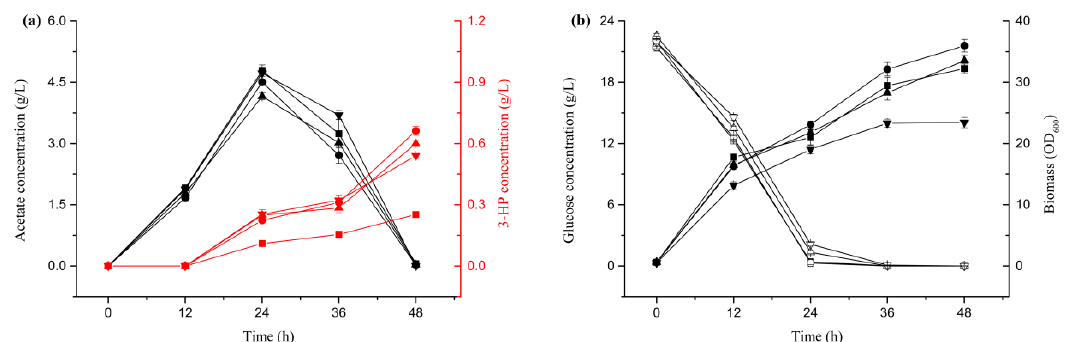
Figure 3. Time profiles of batch fermentations of strains Cgz4 (squares), Cgz5 (circles), Cgz6 (upward triangles) and Cgz7 (downward triangles) with 20 g/L glucose. ( a ) Time profiles of acetate accumulation (black filled symbols) and 3-HP production (red filled symbols). ( b ) Time profiles of glucose consumption (open symbols) and cell growth (filled symbols). Error bars indicate the standard deviations from three independent cultures.